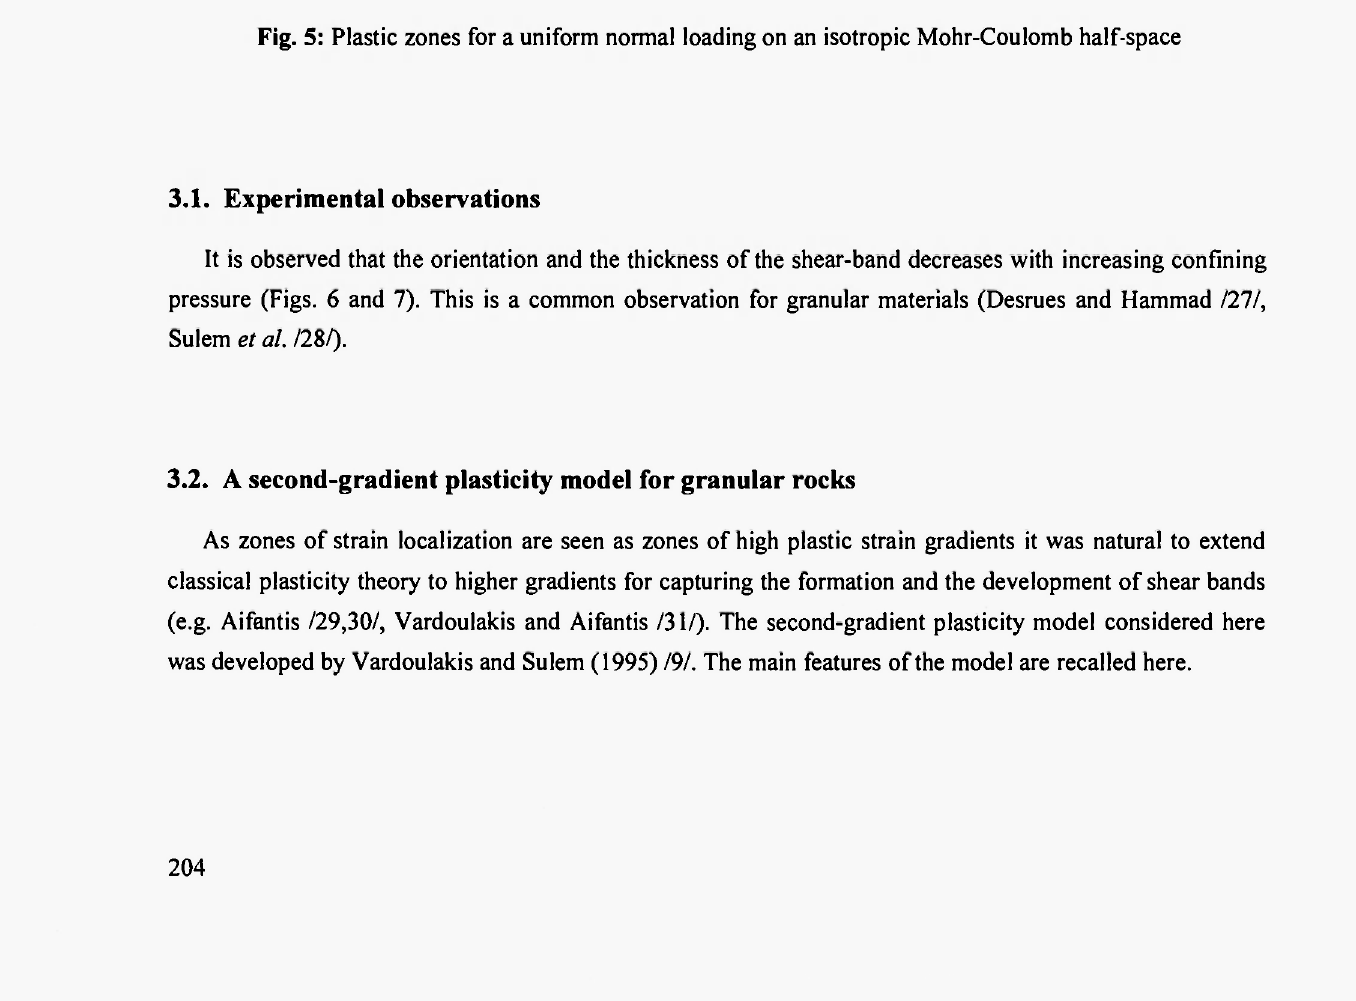
Fig. 5: Plastic zones for a uniform normal loading on an isotropic Mohr-Coulomb